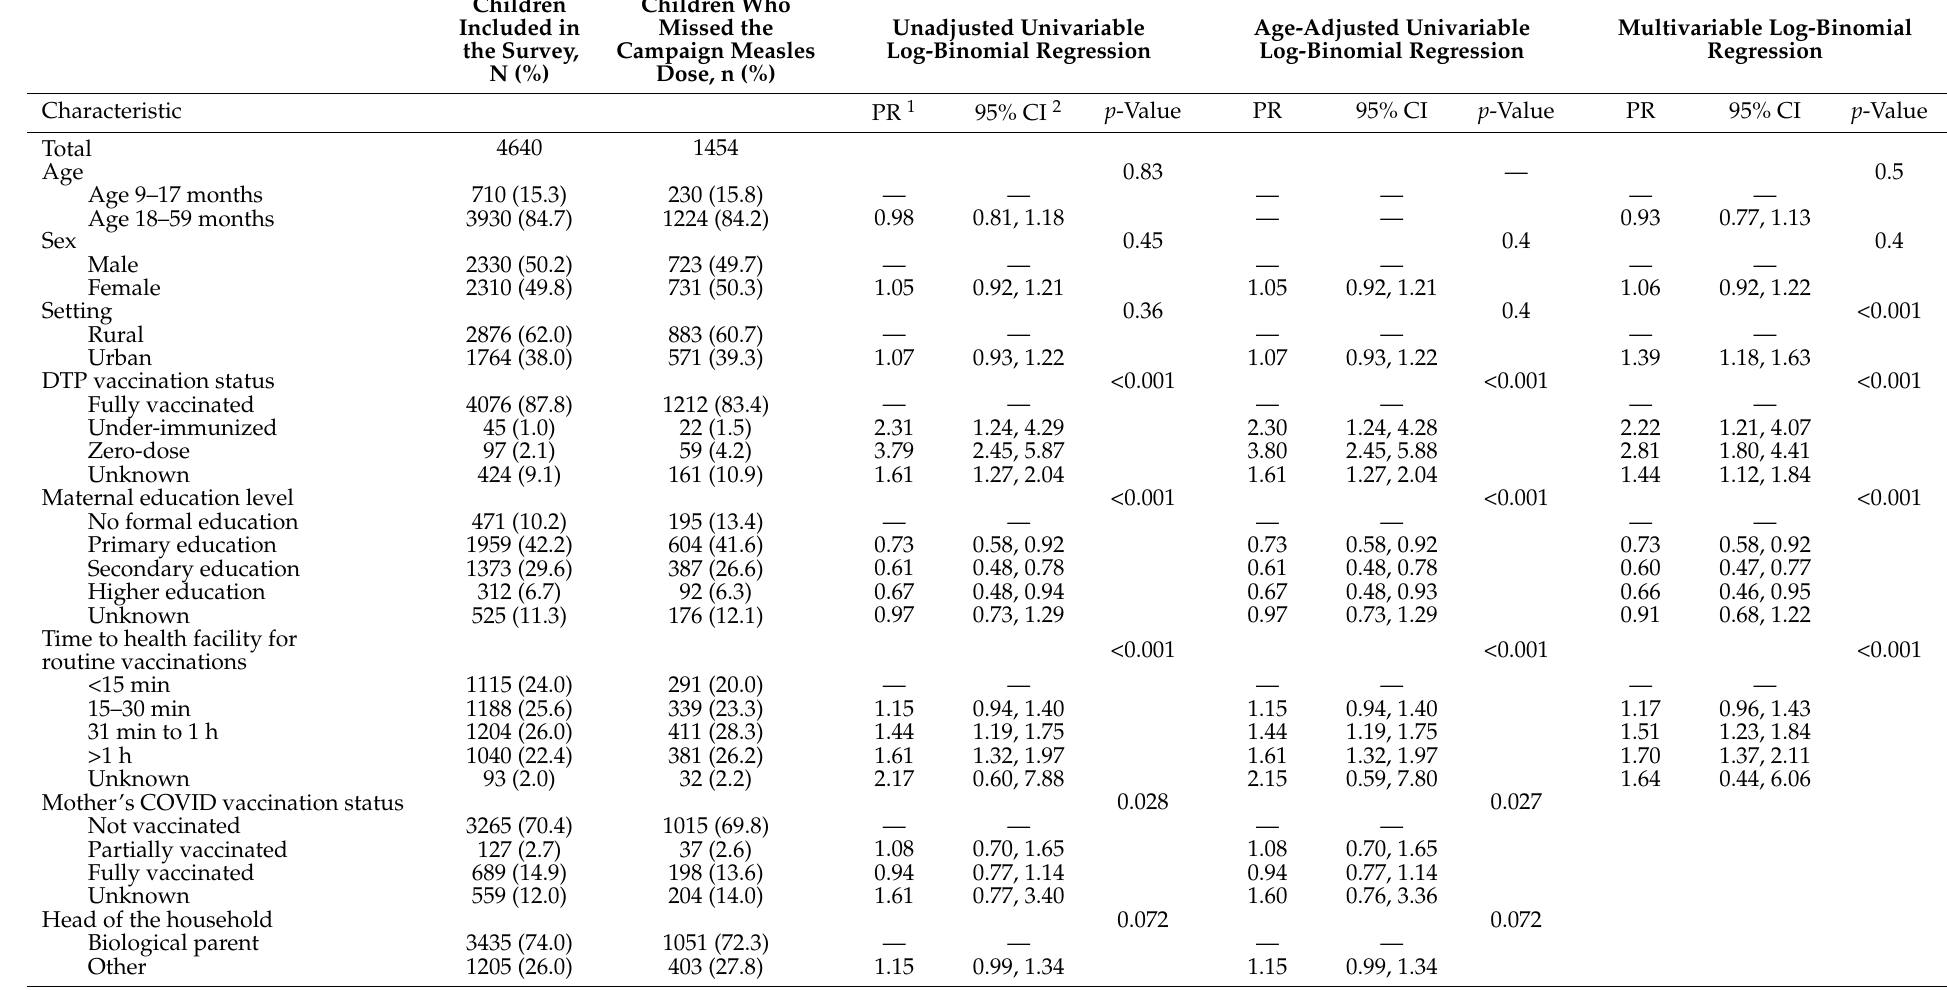
Table 2. Risk factors associated with self-reported missing of campaign MR